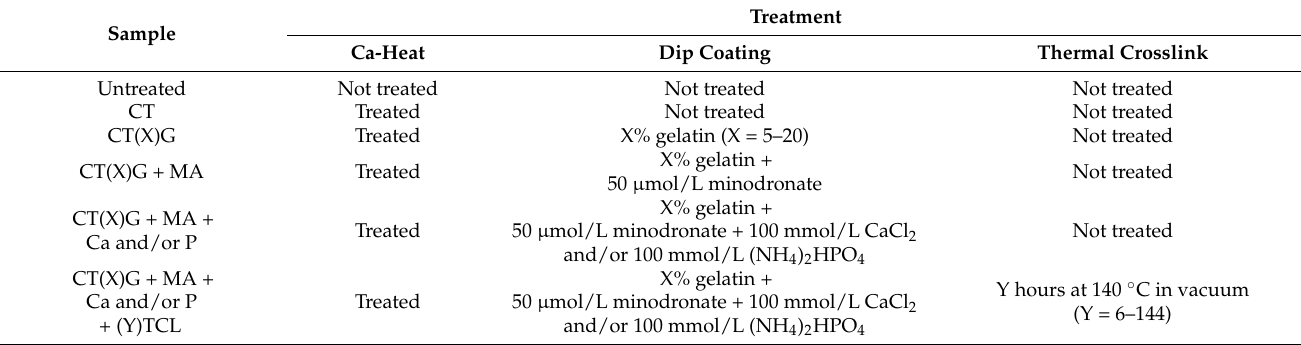
Table 1. Notations of Ti–6Al–4V alloy samples used in this